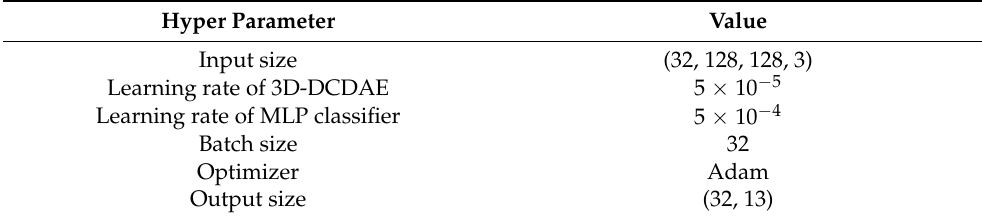
Table 4. Parameters of MLP classifier for music genre